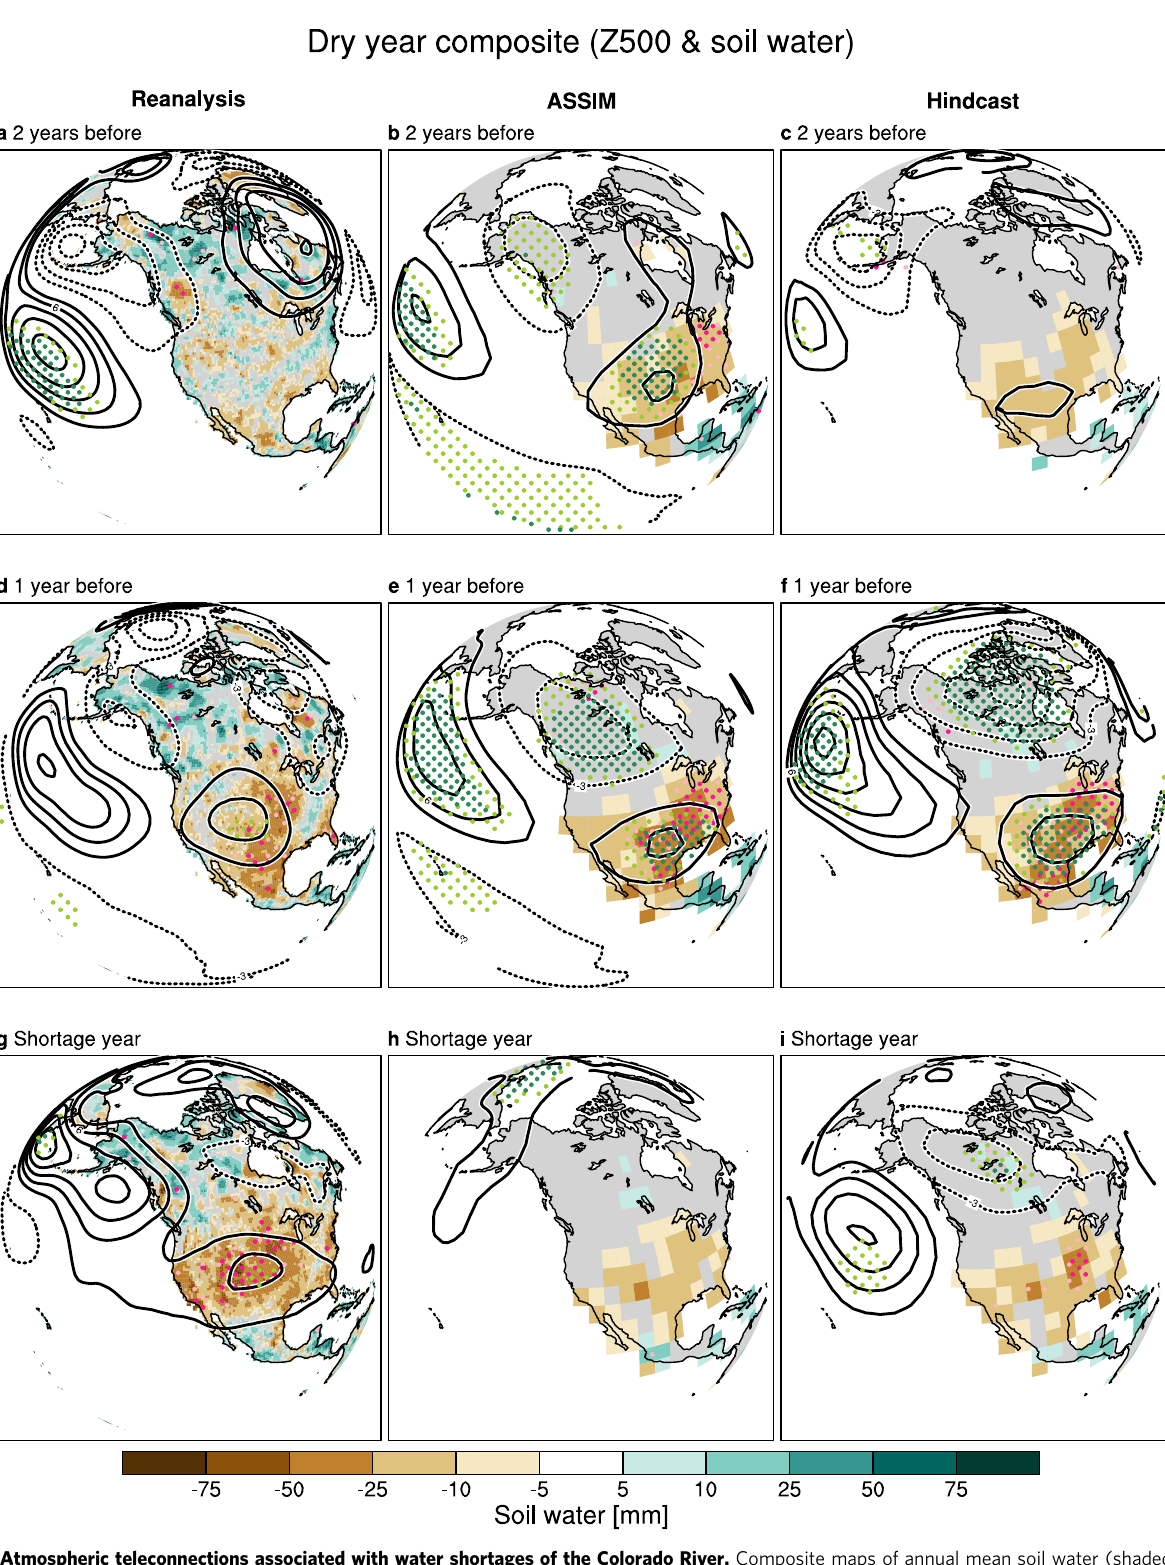
Fig. 3 Atmospheric teleconnections associated with water shortages of the Colorado River. Composite maps of annual mean soil water (shaded) and 500 hPa geopotential height anomalies (contours) in observations (left), the ASSIM run (center), and the 1 – 12 months hindcast run (right) at ( a – c ) 2 years before, d – f 1 year before, and g – i during waters shortage in the Colorado River basin (i.e., yellow shading in Fig. 1). Anomalies are de fi ned as deviations from climatological means and linear trends are removed in each grid. Contour intervals are ±3, ±6, ±9, ±12, ±15, ±18, and ±21 hPa. Zero contours are omitted and negative values are dashed. Light and dark pinks (greens) indicate the statistical signi fi cance at the 90% and 95 % levels with two-side Student ’ s t -test for soil water (geopotential height)